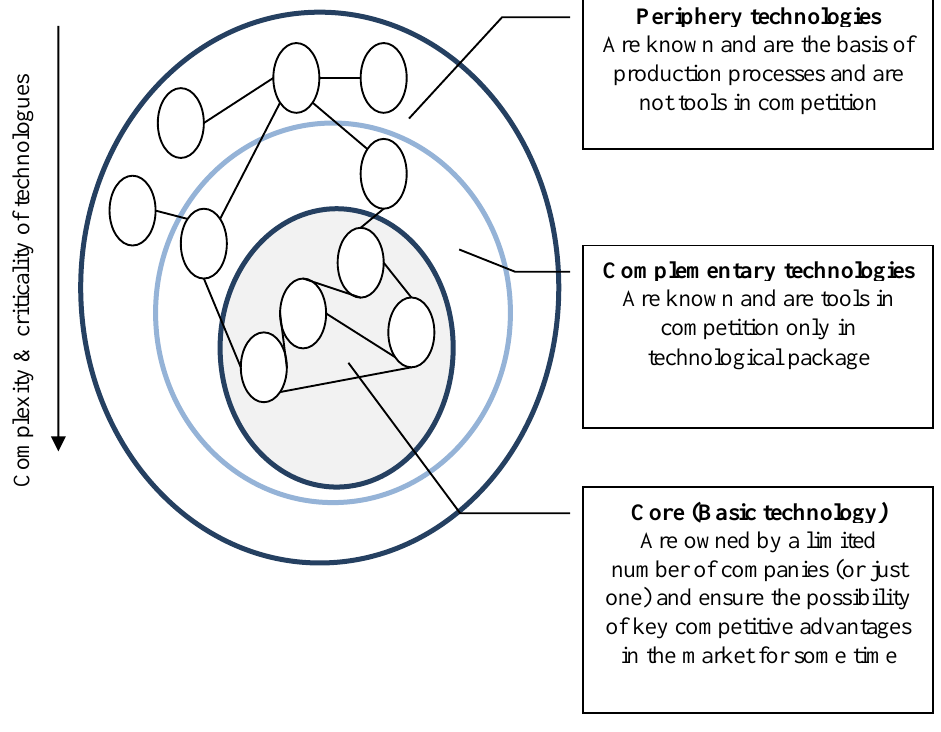
Fig. 4 . Value chain scheme based on technological package